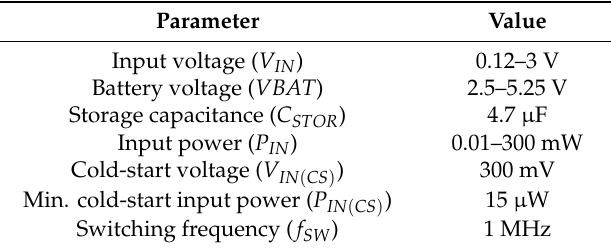
Figure 4. Conceptual schematic of the energy harvesting subsystem. Table 2. Summary of BQ25504 characteristics.